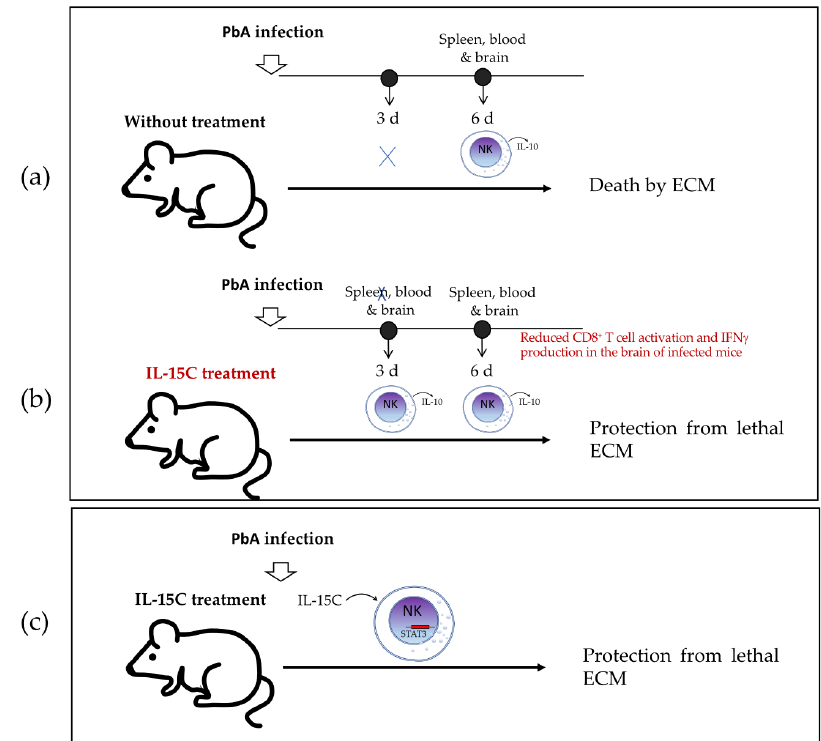
Figure 4. Proposed models of the role of IL-10-producing NK cells in experimental cerebral malaria (ECM). ( a ) NK cells produce IL-10 during ECM in mice infected with PbA at day 6 post-infection, which results in a fatal outcome, whereas ( b ) the treatment with IL-15C promotes an early IL-10 production by NK cells (3 days post-infection), which is sufficient and necessary for the protective effect of IL-15C treatment in preventing the development of ECM and the fatal outcome. In addition, IL-15C treatment decreases CD8 + T- cell activation and IFNγ production in the brain of infected mice at 6 days post-infection. ( c ) In this model, NK cell intrinsic STAT3 is required for the survival-promoting effects of IL-15C treatment of ECM. ECM — experimental cerebral malaria; PbA — Plasmodium berghei ANKA; d — days; IL15C — IL15 and IL15R complex treatment.